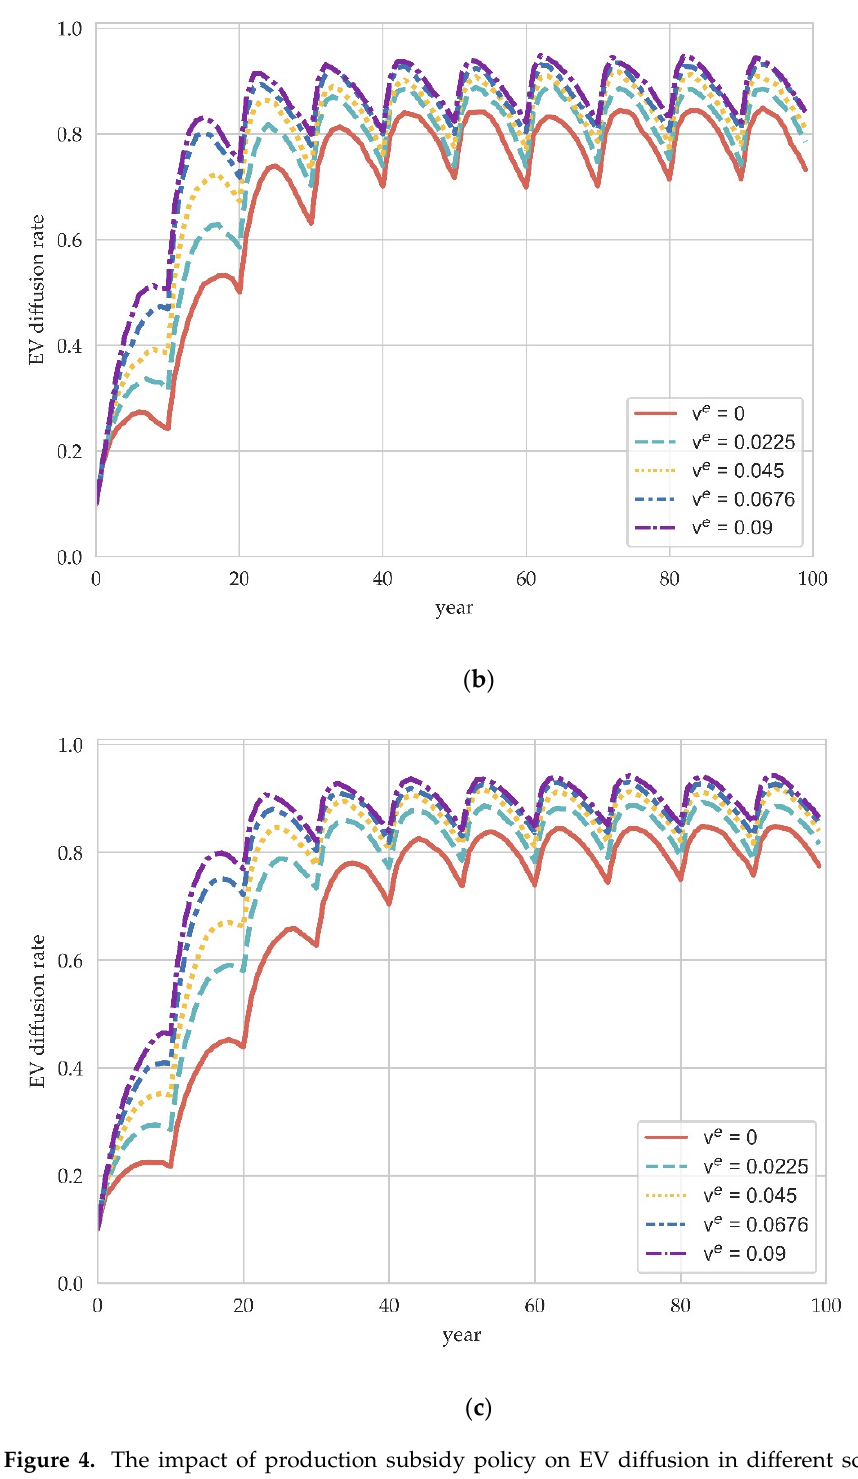
Figure 4. The impact of production subsidy policy on EV diffusion in different scale network. ( a ) 𝑀 = 100 . ( b ) 𝑀 = 200 . ( c ) 𝑀 = 300 . ( a ) M = 100. ( b ) M = 200. ( c ) M =